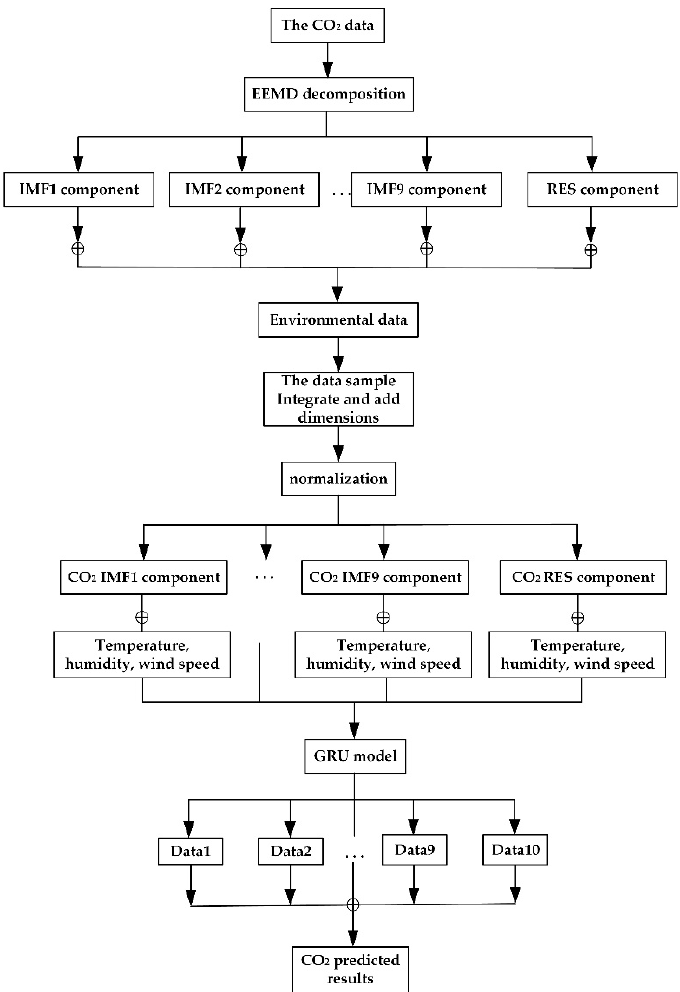
Figure 2. Flow figure of EEMD–GRU